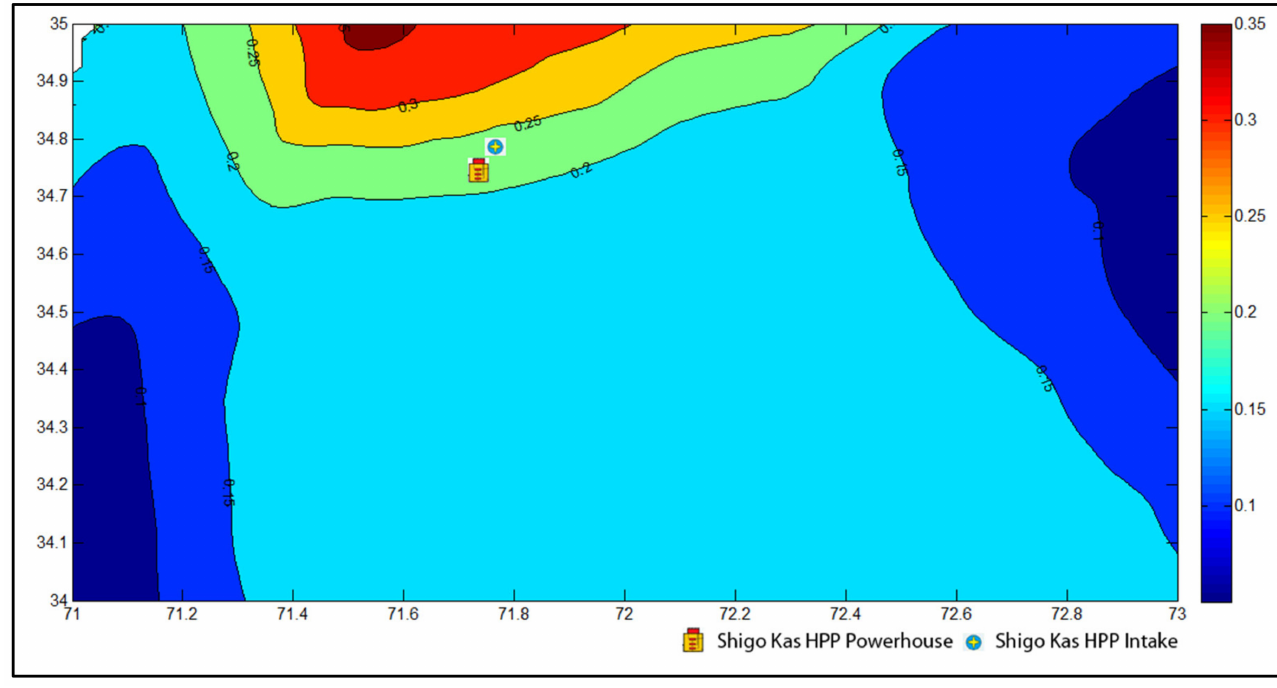
Figure 17. Seismic hazard map of the Shigo Kas HPP area for PGA at a 145-year return period. The legend on the right side of the map shows the PGA in terms of g.